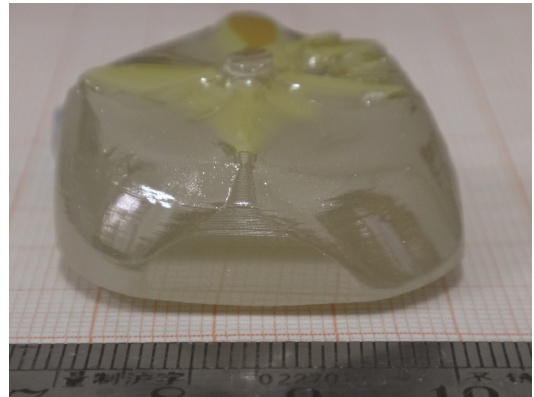
Figure 18. The as-grown NBT-1.5BZT single crystal (scale in mm). Reprinted with permission from [31]. Copyright 2014 John Wiley and